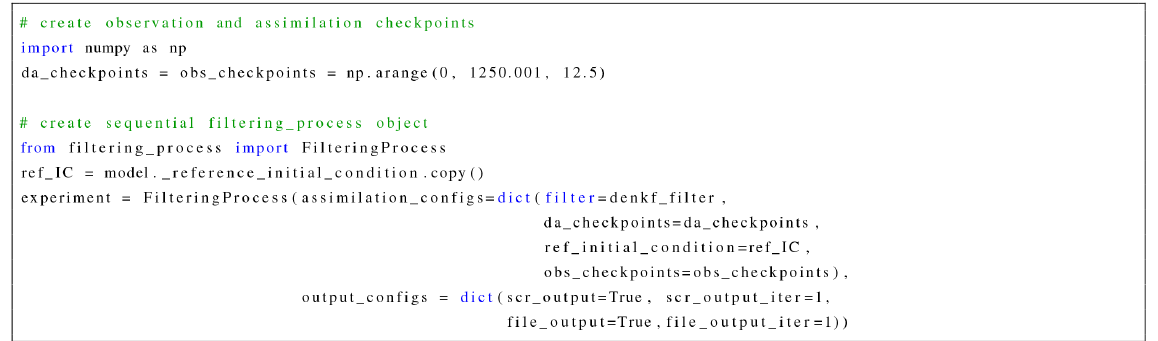
Figure 8. Creating a filter process object to carry out DEnKF filtering using the QG model.